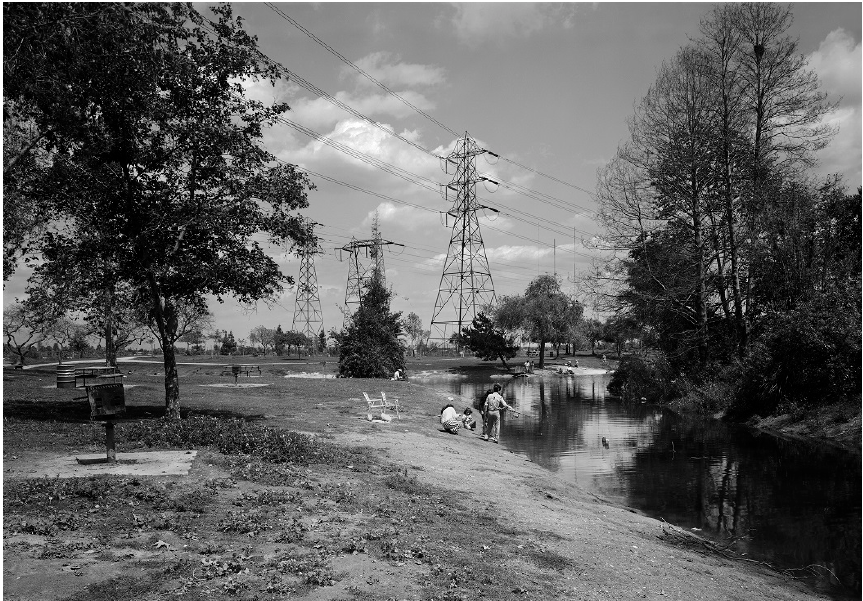
Figure 18. Anthony Hernandez, Public Fishing Areas #17 (1979), © Anthony Hernandez.